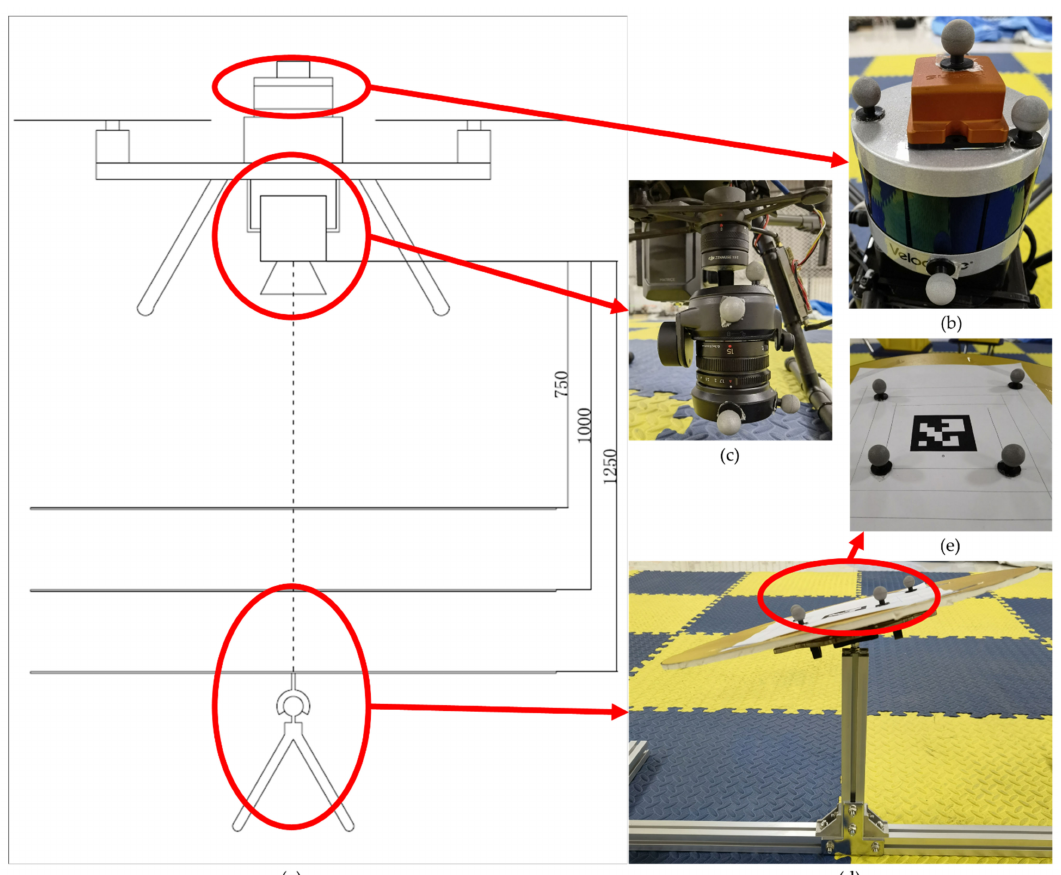
Figure 5. The schematic layout of test equipment and the pasting position of Vicon markers. ( a ) shows the test equipment, including the Lidar-IMU part, camera part on the UAV, and the installation of the ArUco marker on the ground. ( b , c , e ) are the pasting position of the Vicon mark near the Lidar-IMU part, the camera part, and the ArUco marker, respectively. ( d ) is the ball joint support of the ArUco marker.